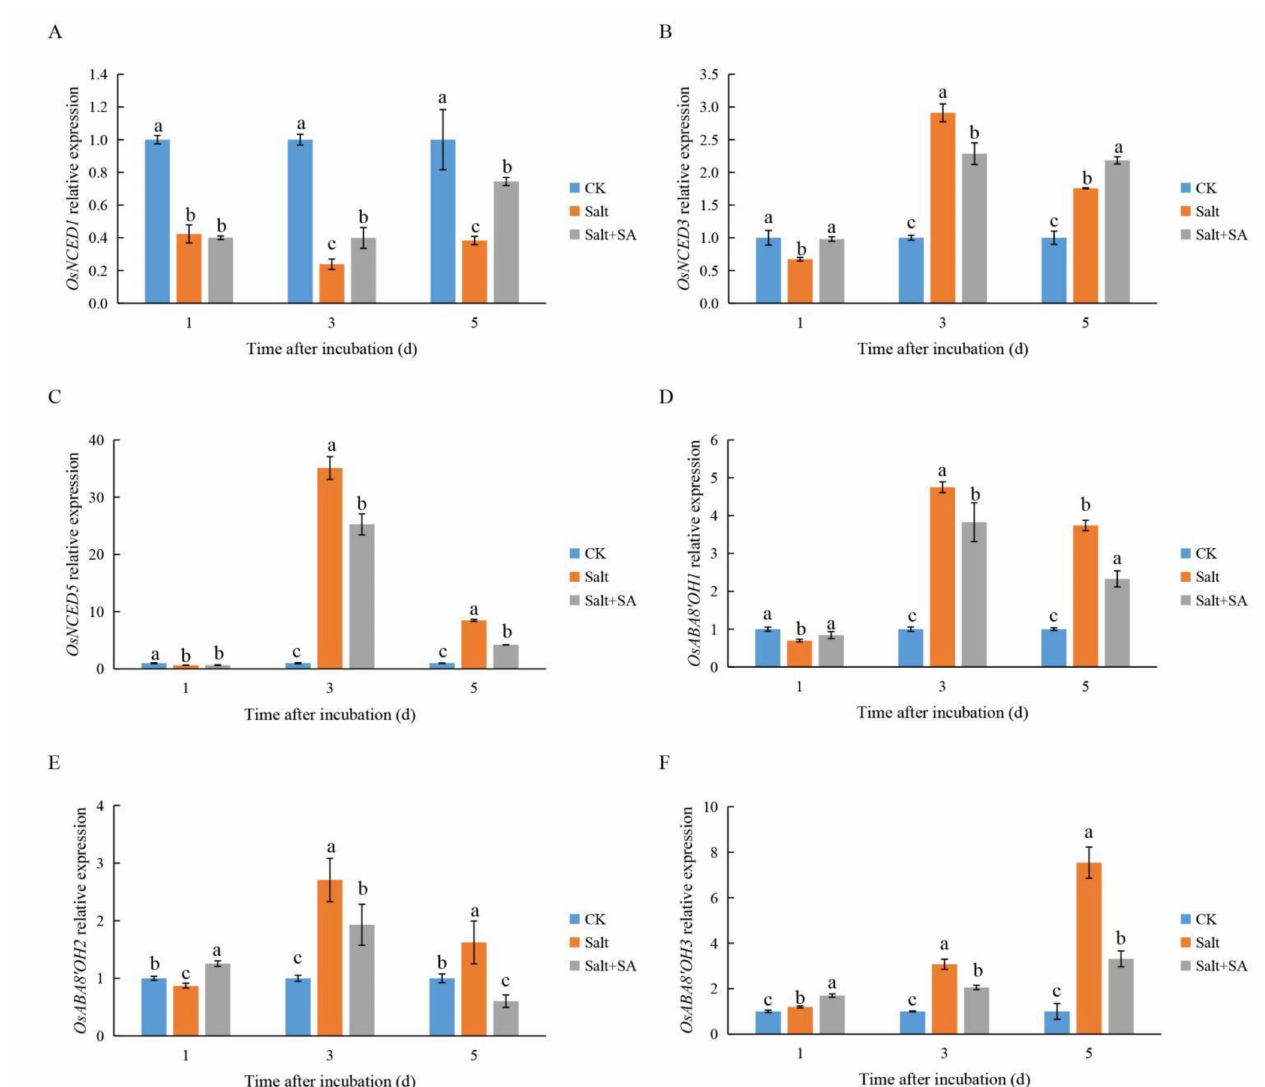
Figure 9. Effects of exogenous salicylic acid (SA) on abscisic acid (ABA) biosynthesis and expression of ABA catalyzing genes under salt stress. Seeds of Nipponbare were incubated in distilled water (CK), 150 mM NaCl (Salt), and 150 mM NaCl + 0.1 mM SA (Salt + SA) for 1, 3, and 5 days. The expressions of ABA biosynthetic genes ( A ) OsNCED1 , ( B ) OsNCED3 , and ( C ) OsNCED5 and catalytic genes ( D ) OsABA8 (cid:48) OH1 , ( E ) OsABA8 (cid:48) OH2 , and ( F ) OsABA8 (cid:48) OH3 were recorded. Data are presented as means ± SE. Different lowercase letters indicate significant differences between treatments ( p <